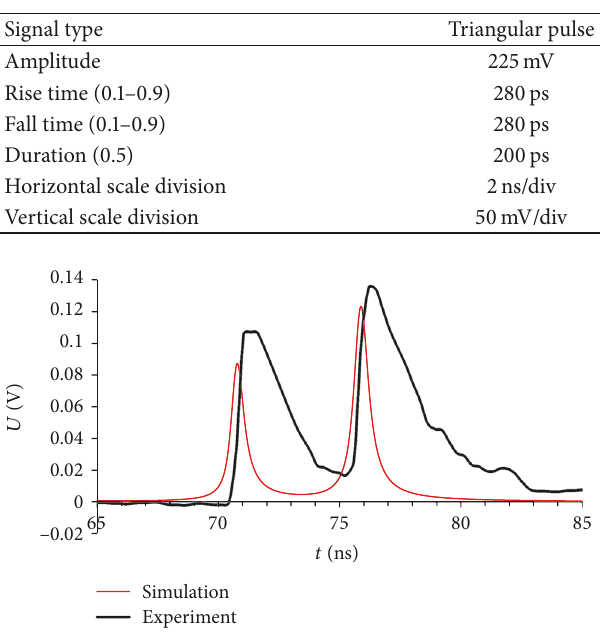
Figure 9: Comparison of simulated and experimental results of waveforms at the far end of the probing line ( 𝑉4 ) with open circuit at both ends of the probed conductor.